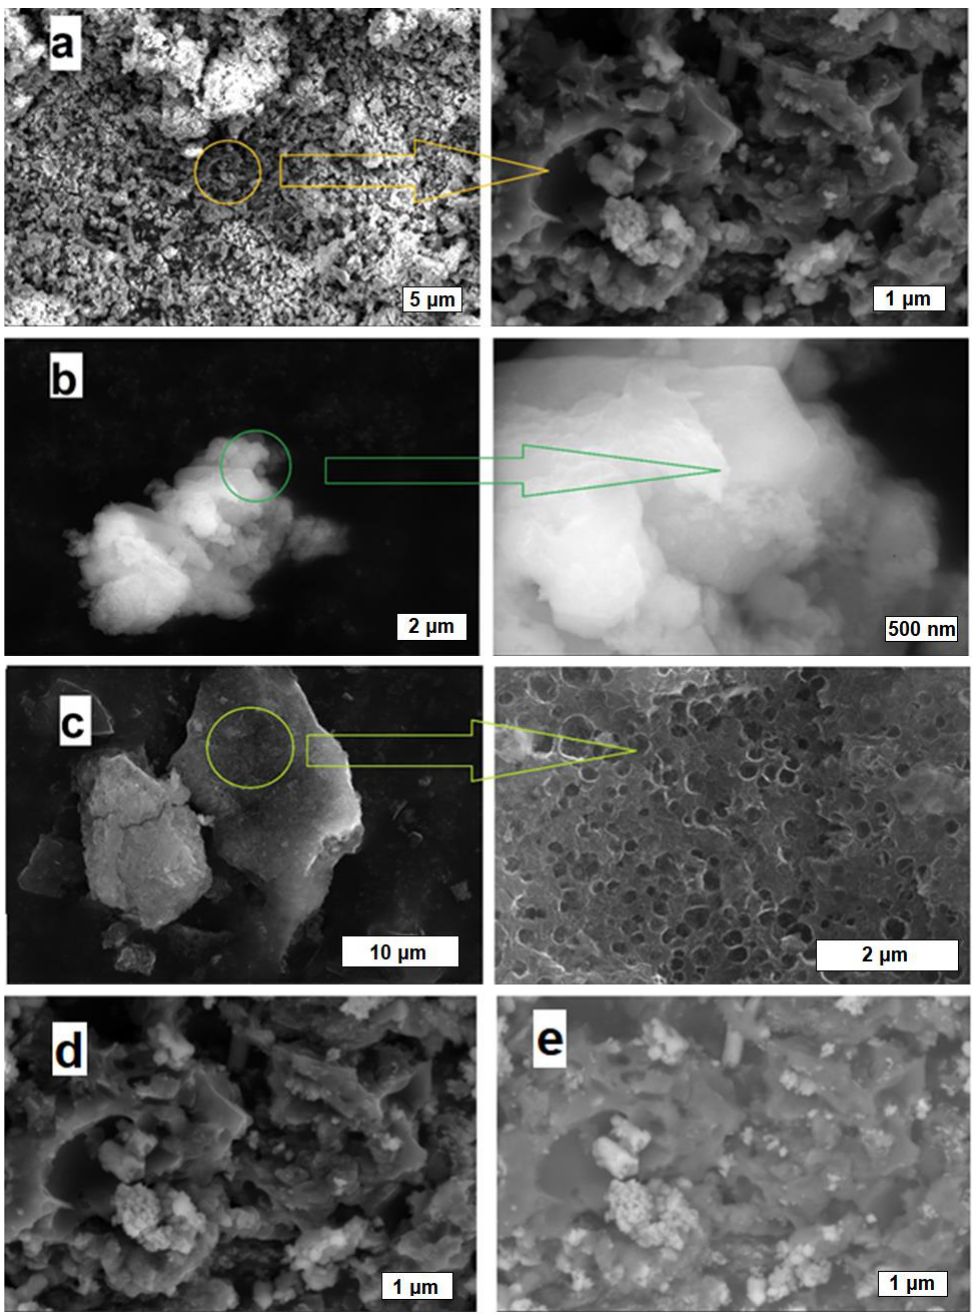
Figure 2. SEM images of ( a ) VR-KOH, ( b ) VR-Ca(OH) 2 , ( c ) VR-MgO; and ( d ) SE and ( e ) BSE imaging mode of VR-KOH.